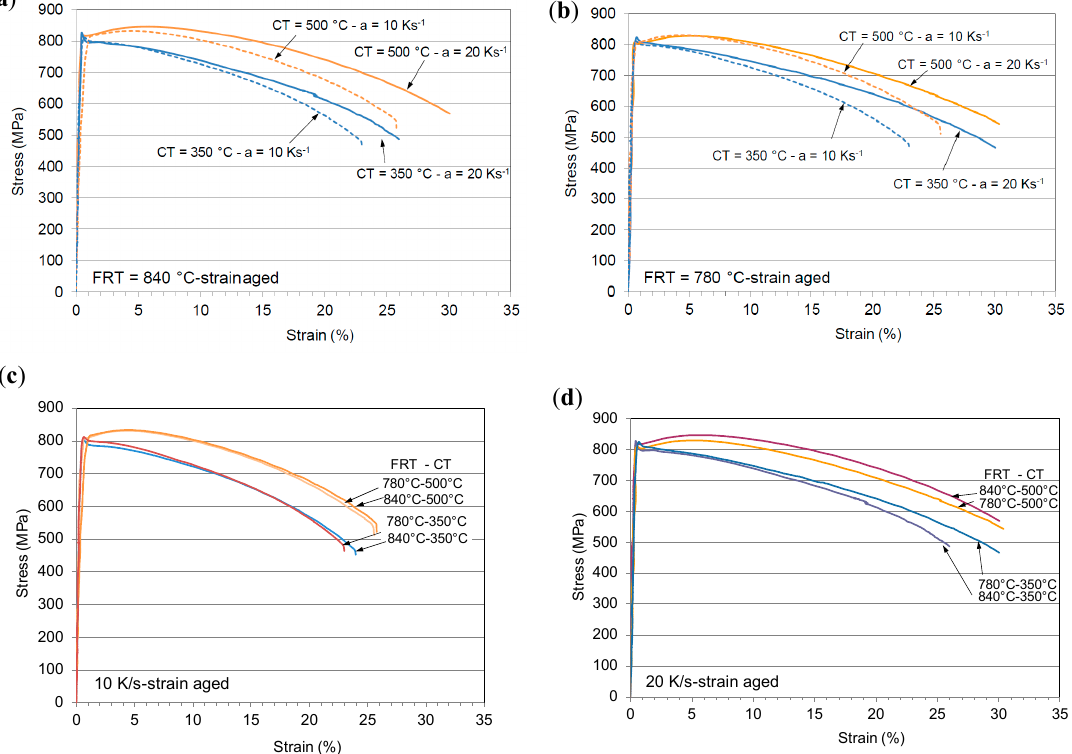
18 of 23 Figure 12. Stress–strain curves of samples with the prescribed TMP parameters; ( a ) FRT = 840 °C, ( b ) FRT 780 °C, ( c ) a = 10 K·s − 1 and ( d ) a = 20 K·s − 1 . 3.7. Effect of the TMP Parameters on Strain Aging Figure 13 shows the stress–strain curves of the samples after aging. Table 3 lists the different S 2 - values assessed according to Section 2.5. It was interesting to observe that the yield strength after